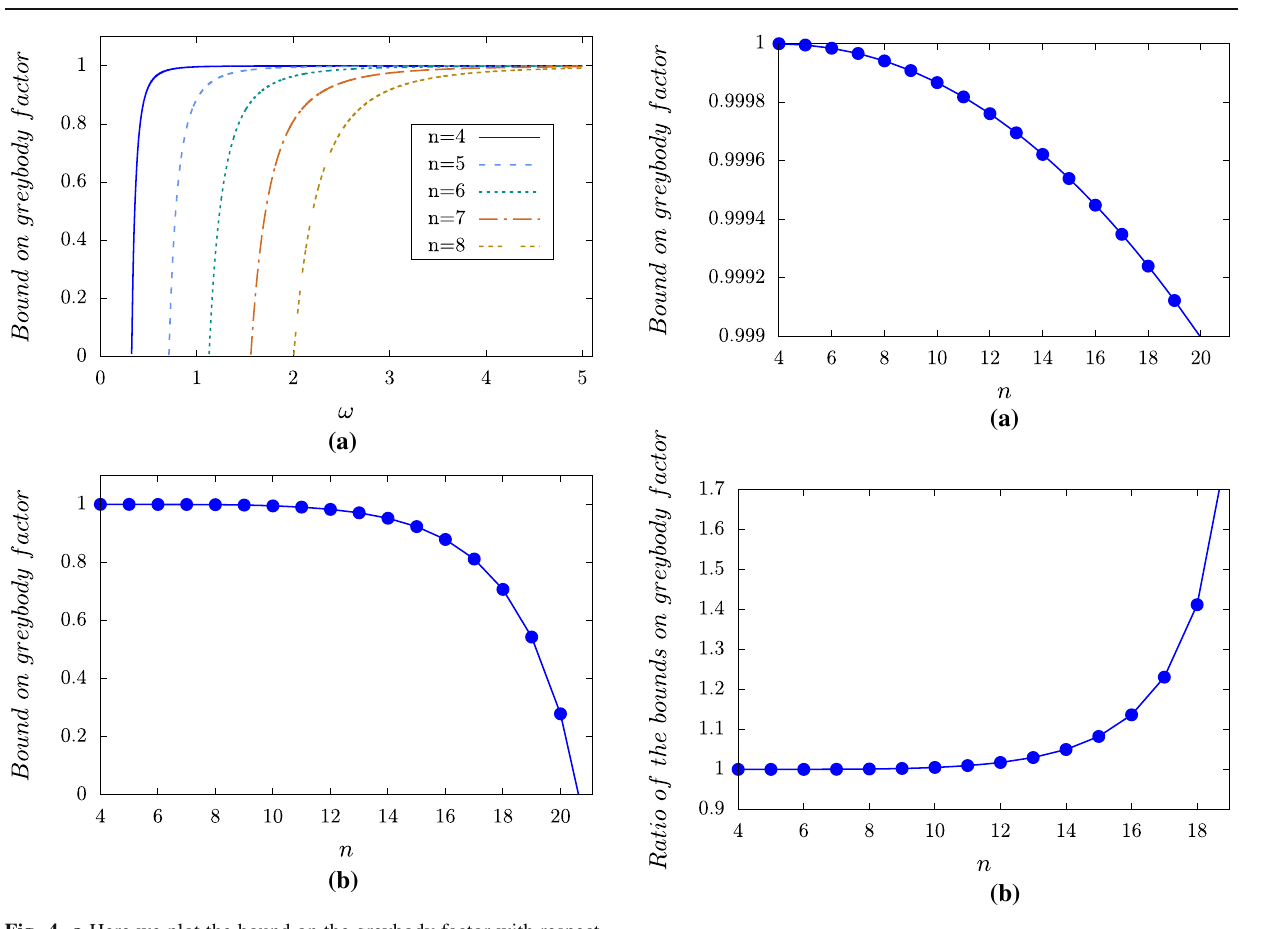
Fig. 4 a Here we plot the bound on the greybody factor with respect Fig. 5 a Here we plot thebound onthe greybody factor, corresponding to the frequency ω for l = 0, r H = 1 and different values of spacetime to a brane-localized scalar field, with respect to different spacetime dimension n . b The plot of the bound on the greybody factor with dimension n for l = 1, r H = 1. b The plot of the ratio of the bounds respect to varying spacetime dimensionality n for l = 0, r H = 1 and a on the greybody factor, corresponding to the brane to bulk scalar field, conveniently chosen frequency ω = 8. Both of the plots correspond to √ with respect to varying dimension n for l = 1, r H = 1. For both of the ω 2 − V a scalar field in the Bulk and the considered case is h = cases the frequency ω = 8 is chosen conveniently and the